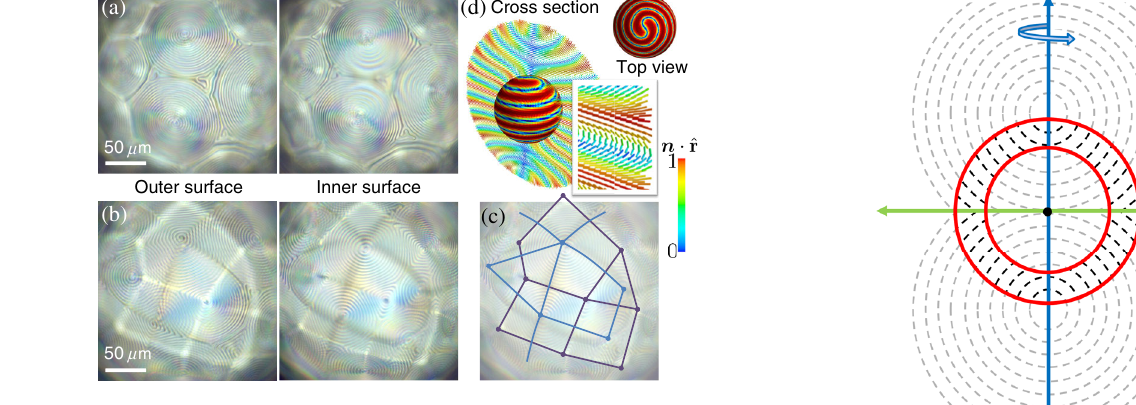
FIG. 4. Ordering focal conic domains on a sphere. CLC shells with 7-mM SDS in the outer phase, without (a) and with (b) 7-mM SDS in the inner phase, have thin stripes that form double-spiral domains. The left micrographs focus on the outer surface of the shell; the right micrographs focus on the inner surface. The pitch is 5 μ m. In panel (c), blue lines represent the edges of FCDs on the outer surface of (b), while purple lines represent the edges of FCDs on the inner surface. The cholesteric polygonal texture comes from the staggered packing of FCDs. (d) A simulated CLC shell ( 2 . 2 - μ m diameter, 0 . 70 - μ m thickness, and 0 . 42 - μ m pitch) with matching homeotropic anchoring con- ditions ( W 0 ≈ 1 . 5 × 10 − 5 J = m 2 ) on the inner and outer surfaces. The top view shows the double-spiral pattern of the outer shell surface, while the cross section additionally shows the patterning of the inner shell surface. The shell has no defect in n , only two defects in the pitch axis, located underneath the double spirals. The coloring indicates the magnitude of n along the radial direction ˆ r (i.e., perpendicular to the shell surfaces).